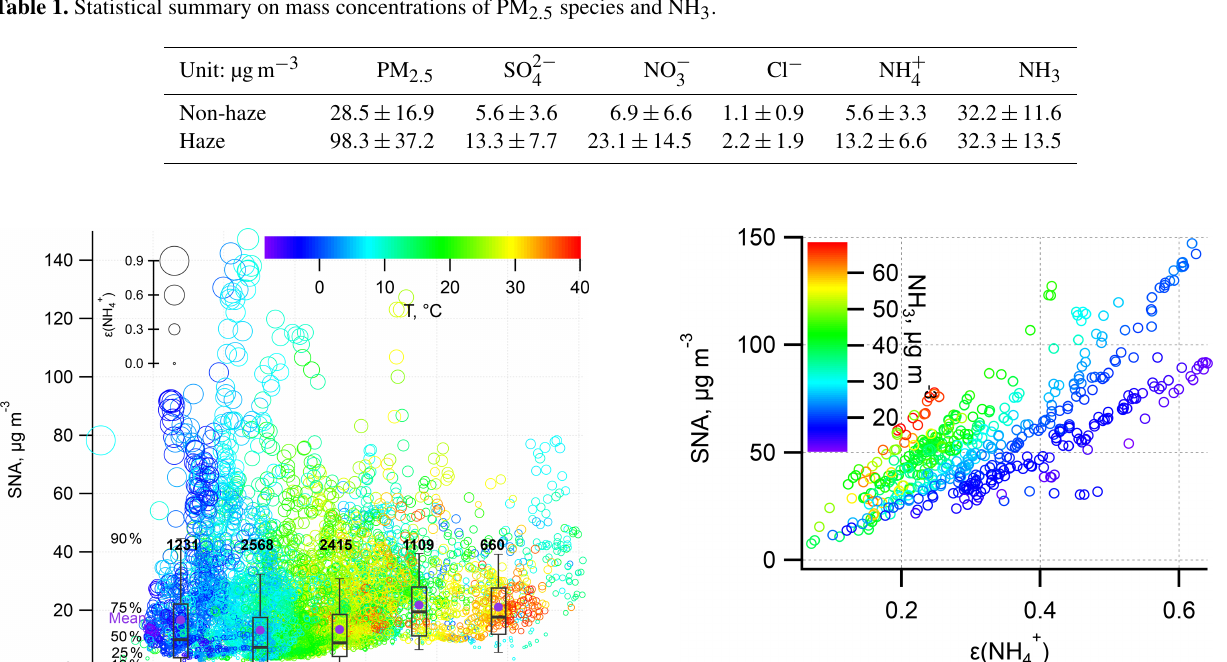
Table 1. Statistical summary on mass concentrations of PM 2 . 5 species and NH 3 .